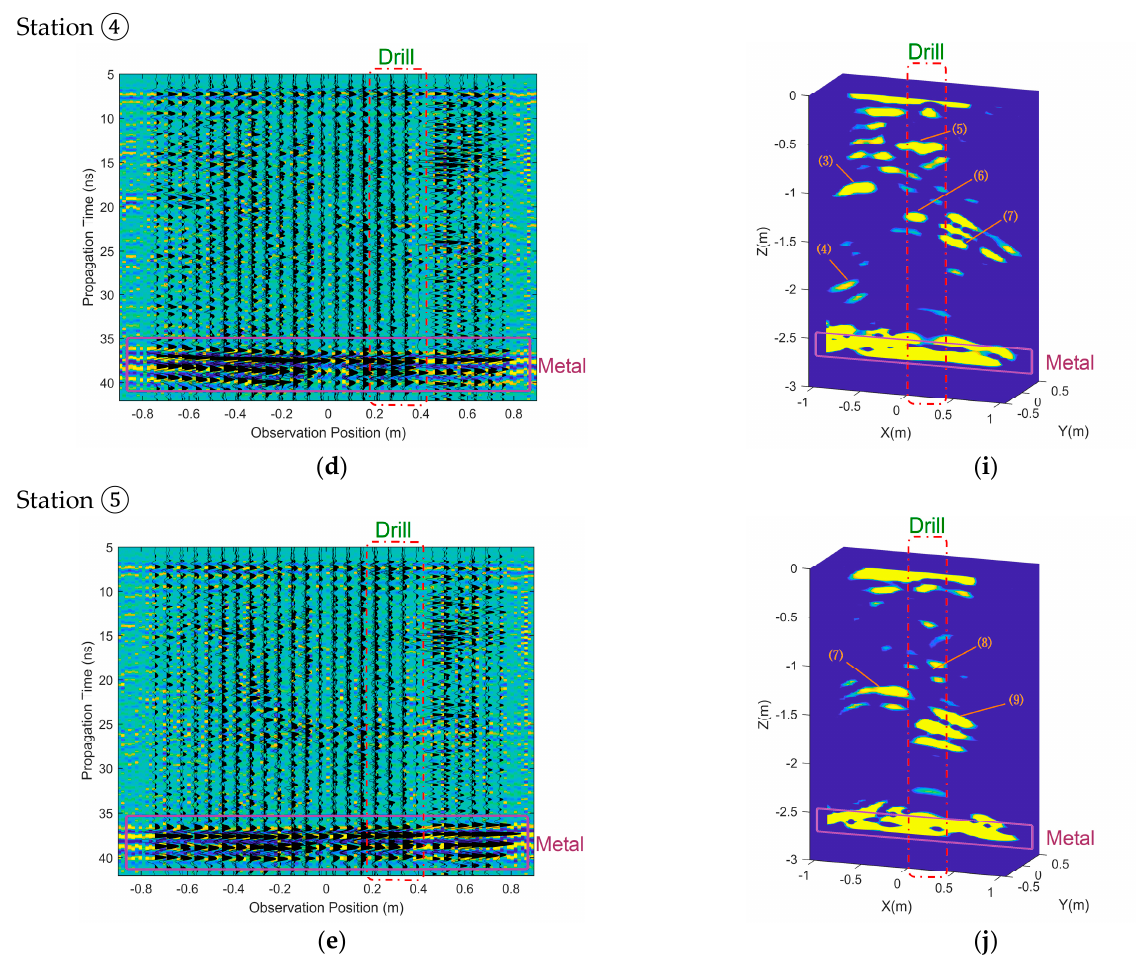
Figure 11. Received echoes from the 12 channel antennas in the five stations based on the spectral window ( a – e ), and their corresponding RTM imaging ( f – j ).